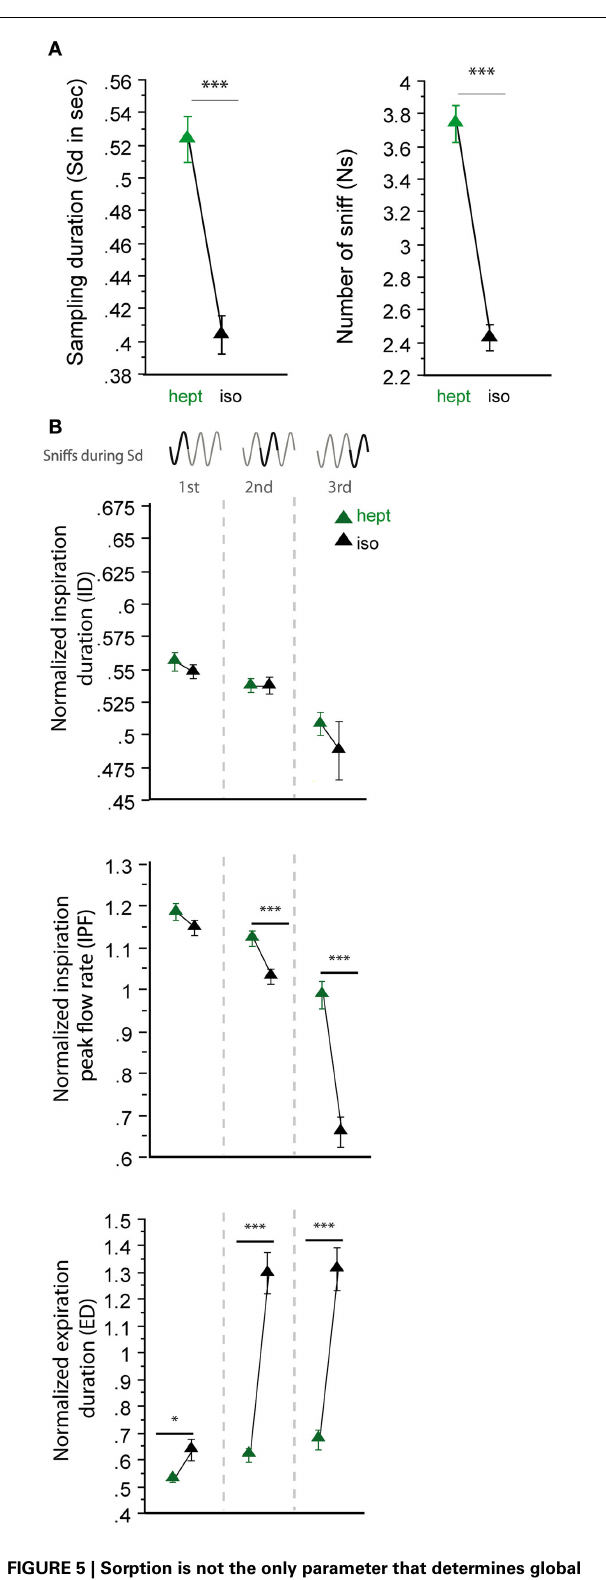
FIGURE 5 | Sorption is not the only parameter that determines global sniffing variations. (A) Global sampling parameters (mean ± s.e.m.), Sd (left), and Ns (right), for non-enantiomer odor pair: hept (green)/iso (black)